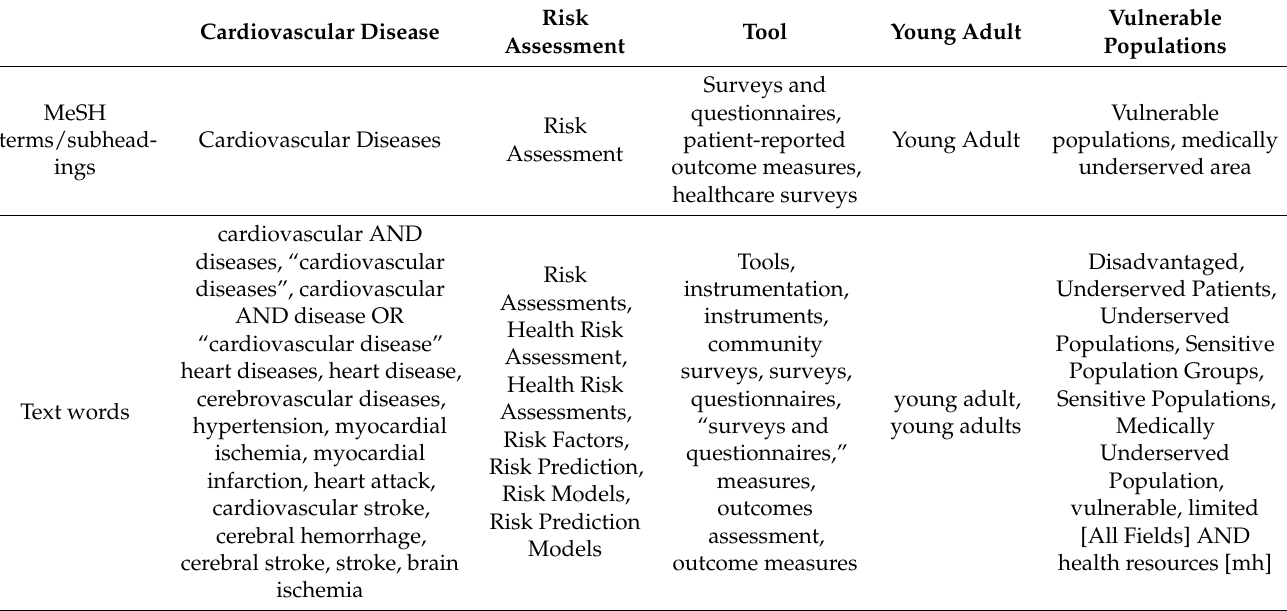
Table 1. Concept table for the literature search.